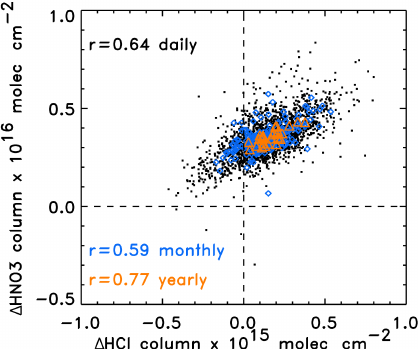
Figure 7. The differences between simulated and observed columns at Jungfraujoch for HCl are correlated with the differences for HNO 3 , whether considering daily average (black), monthly average (blue) or yearly average (orange) values.